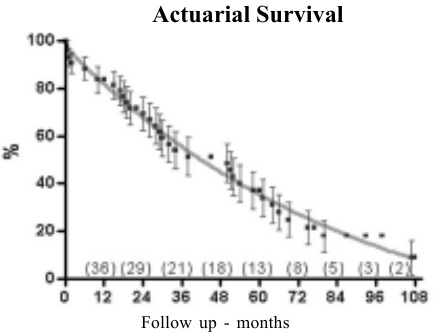
Fig. 1 - Actuarial survival curve (Kaplan-Meier) after dynamic cardiomyoplasty. The light-blue line represents the curve obtained by non-linear regression. The numbers in parenthesis indicate the number of patients in each study period.